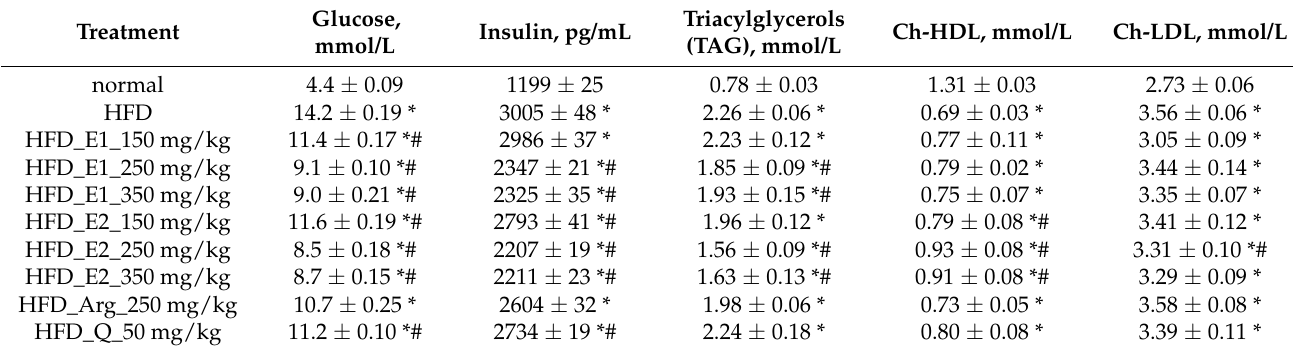
Table 4. The hypoglycemic activity of the investigated extracts under of high-fructose diet (M ± m, n = 6). HFD—high fructose diet group; HFD_E1—high fructose diet group supplemented with extract 1 (E1); HFD_E2—high fructose diet group supplemented with extract 2 (E2); HFD_E2—high fructose diet group supplemented with extract 2 (E2); HFD_Arg— high fructose diet group supplemented with arginine; HFD_Q—high fructose diet group supplemented with quercetin; *—indicates significant difference relative to normal ( p < 0.05); #—indicates significant difference relative to HFD ( p < 0.05). Glucose, Triacylglycerols Treatment Insulin, pg/mL Ch-HDL, mmol/L Ch-LDL, mmol/L mmol/L (TAG), mmol/L